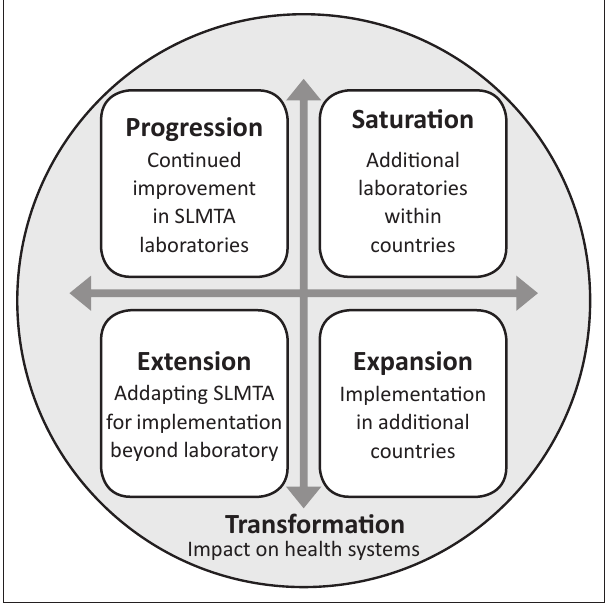
FIGURE 1: Future directions of the SLMTA